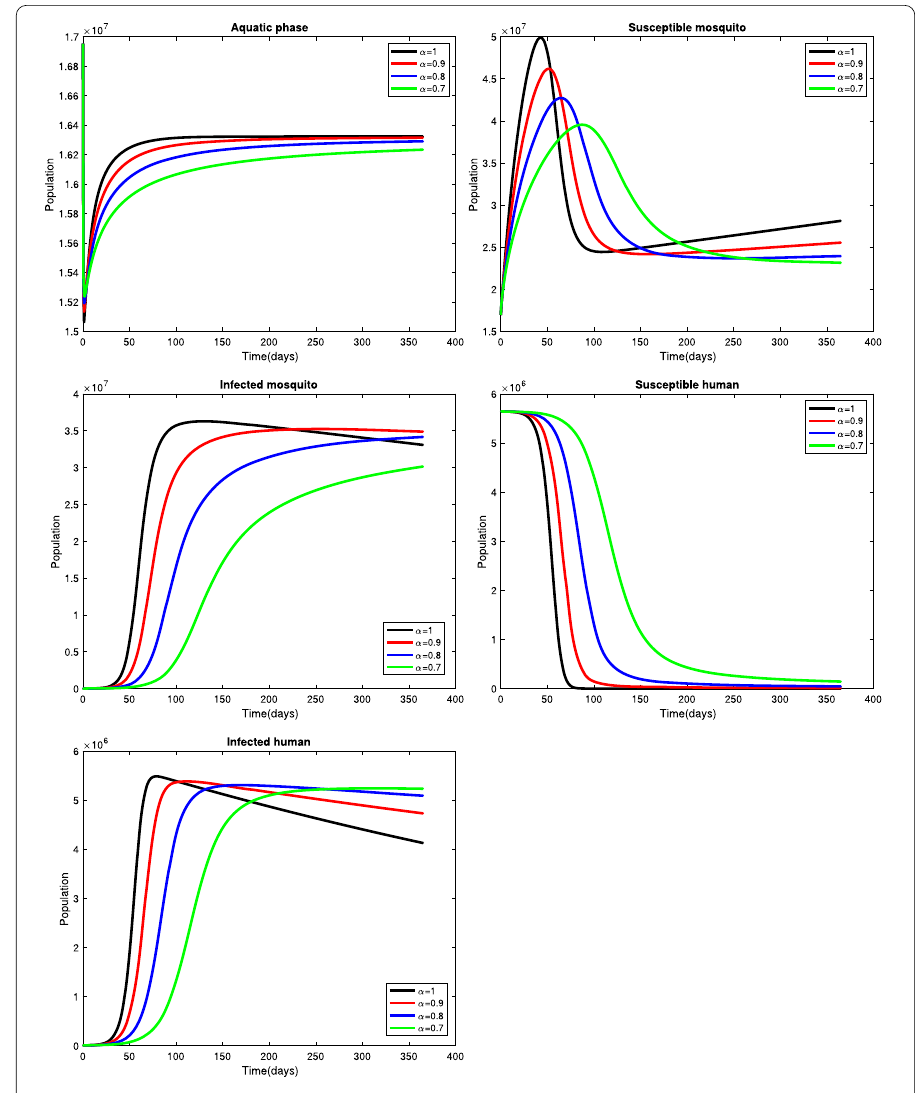
Figure 4 Numerical solution of model (4) with the parameter values q = 0.8, φ = 5.6, b = 0.7, β m = 0.09091, β h = 0.0714, μ A = 0.24, μ m = 0.04, μ h = 3.65 × 10 – 5, ρ h = 0.001, C = 3 N h , σ A = 0.15, γ h = 0.000014285. R 0 >